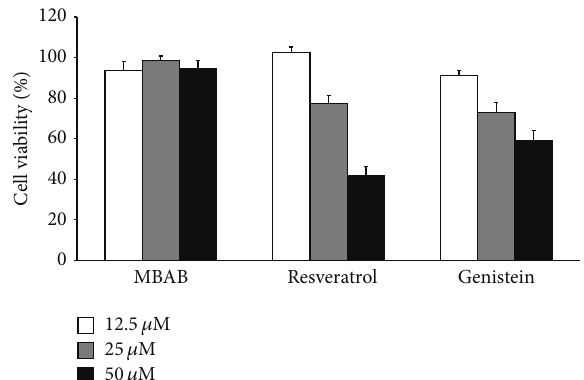
Figure 2: Effect on cell viability in 3T3-L1 cells. The cell viability of the vehicle was set at 100%. The data represent the mean ± SD of the triplicate experiments.